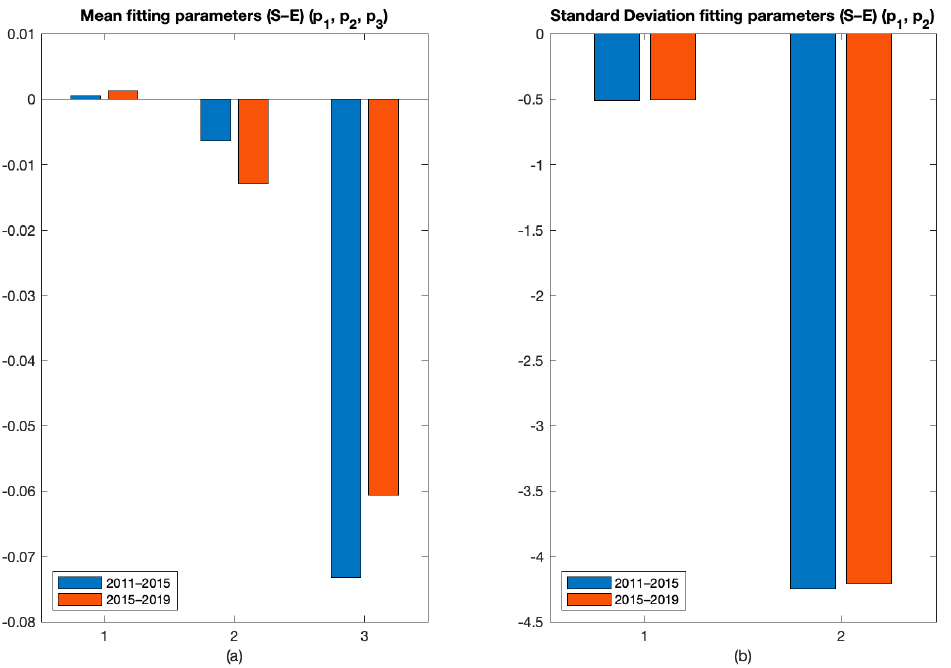
Figure 24. Fitting parameters of the entropy-energy dispersions in the two periods for the Colosseum: ( a ) parameters of the mean model; ( b ) parameters of the standard deviation model.